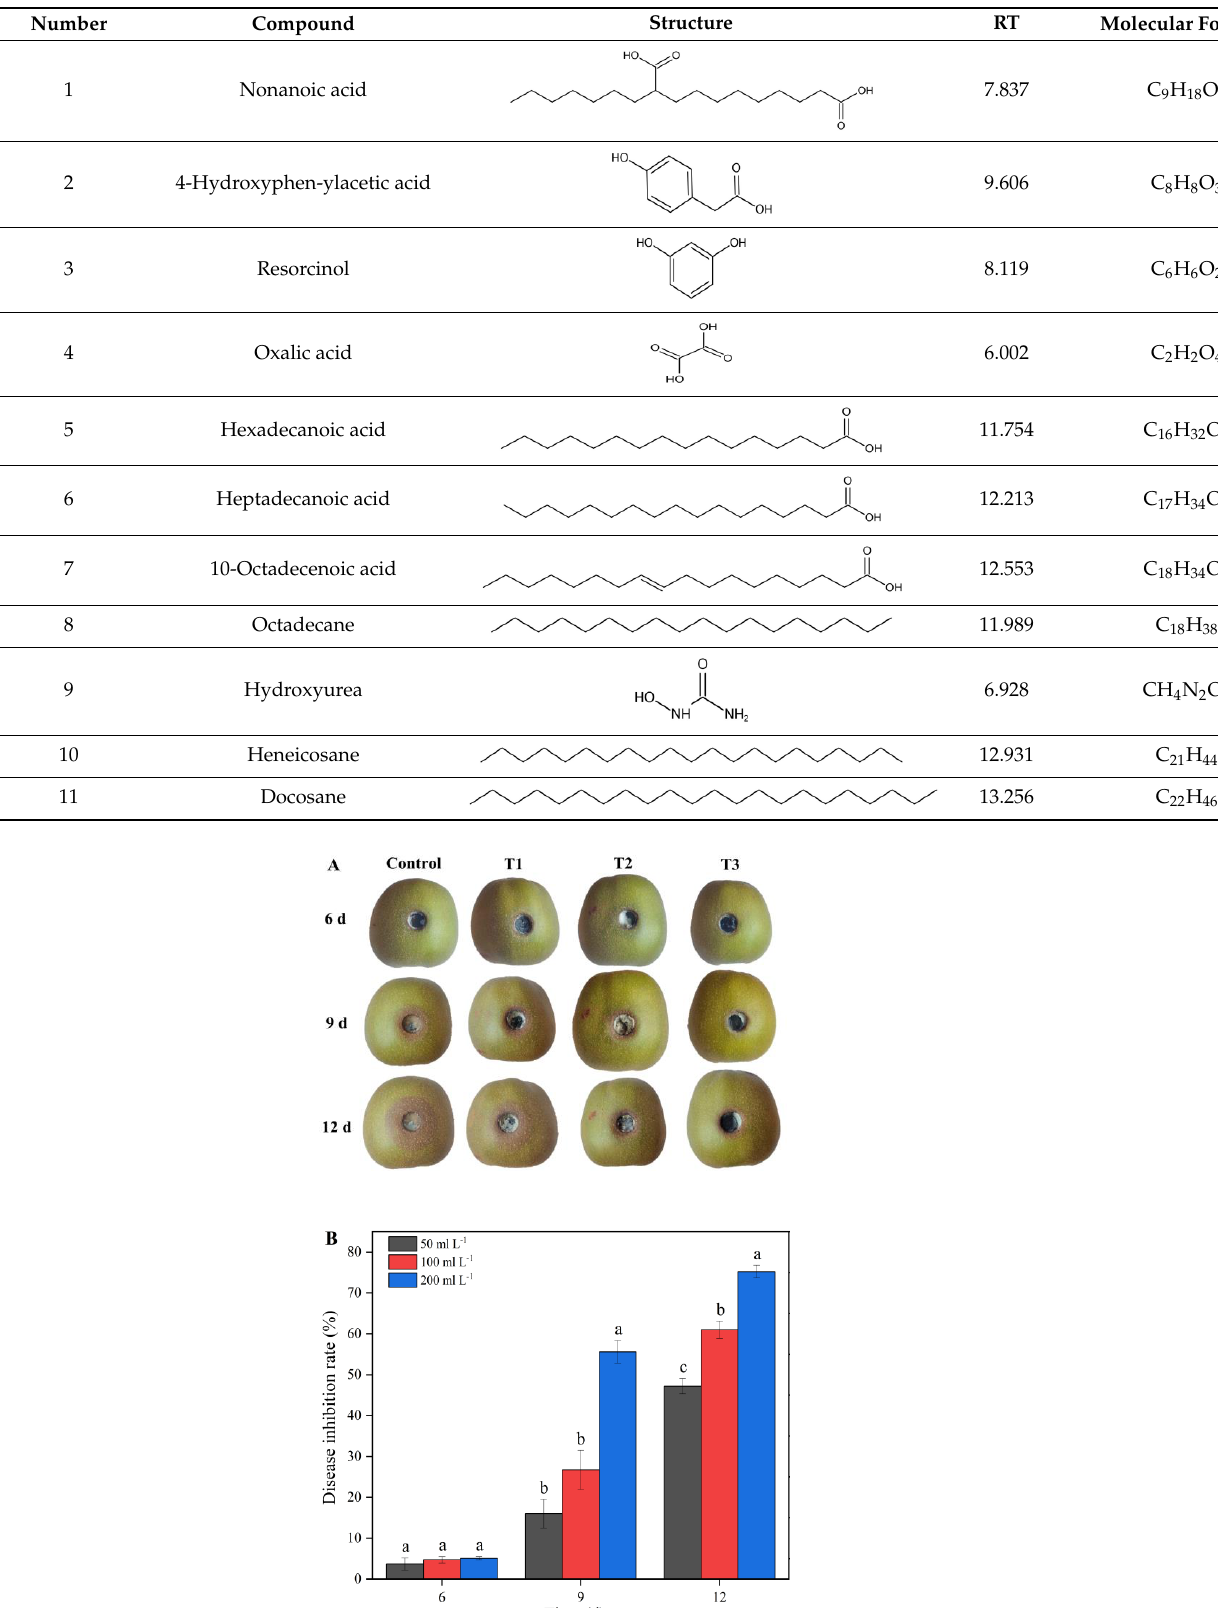
Table 4. Bioactive molecules identified from the aseptic filtrate of strain J-1 by GC–MS analysis.